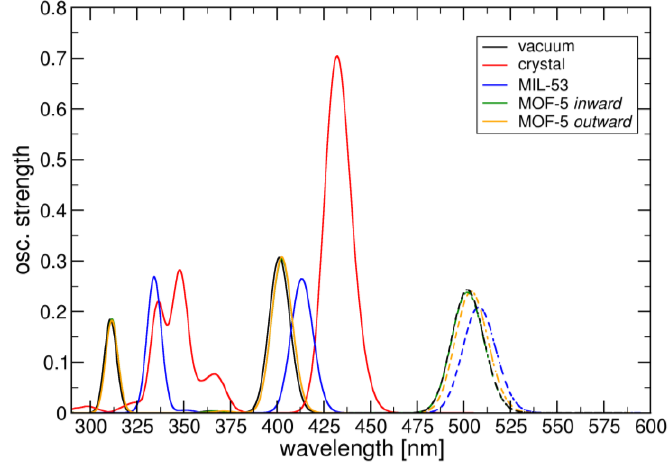
Figure 10. DFT/MRCI computed absorption (full lines) and emission (dashed lines) signatures of MIA in vacuum, neat crystal and MOF environments.